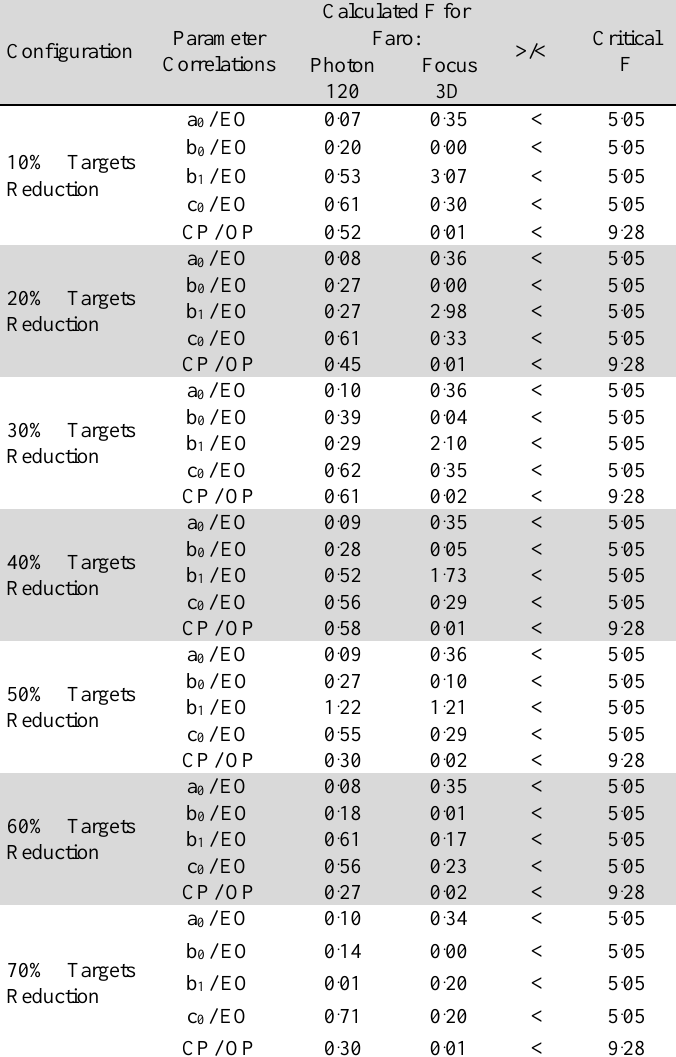
Table 4. F-variance ratio test for different targets